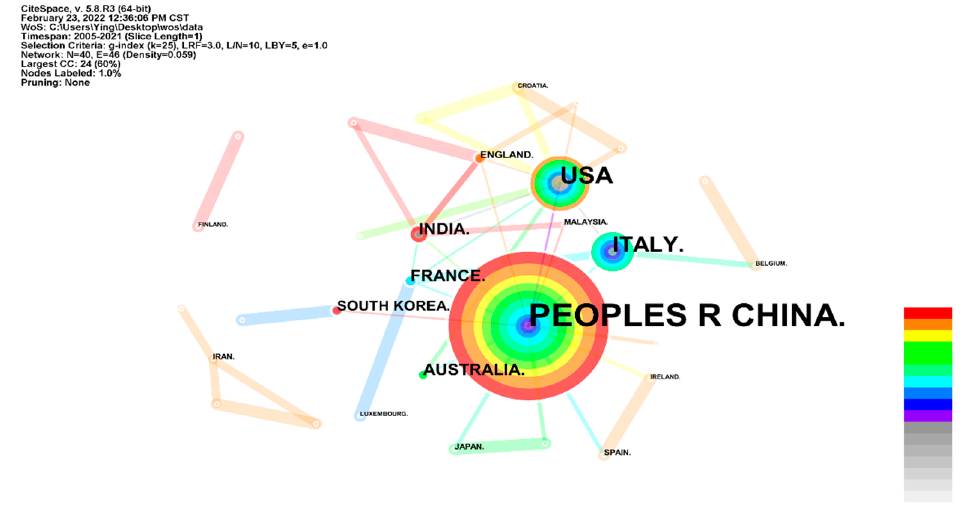
Figure 4. Country co-authorship network in research on LbL self-assembly coating on